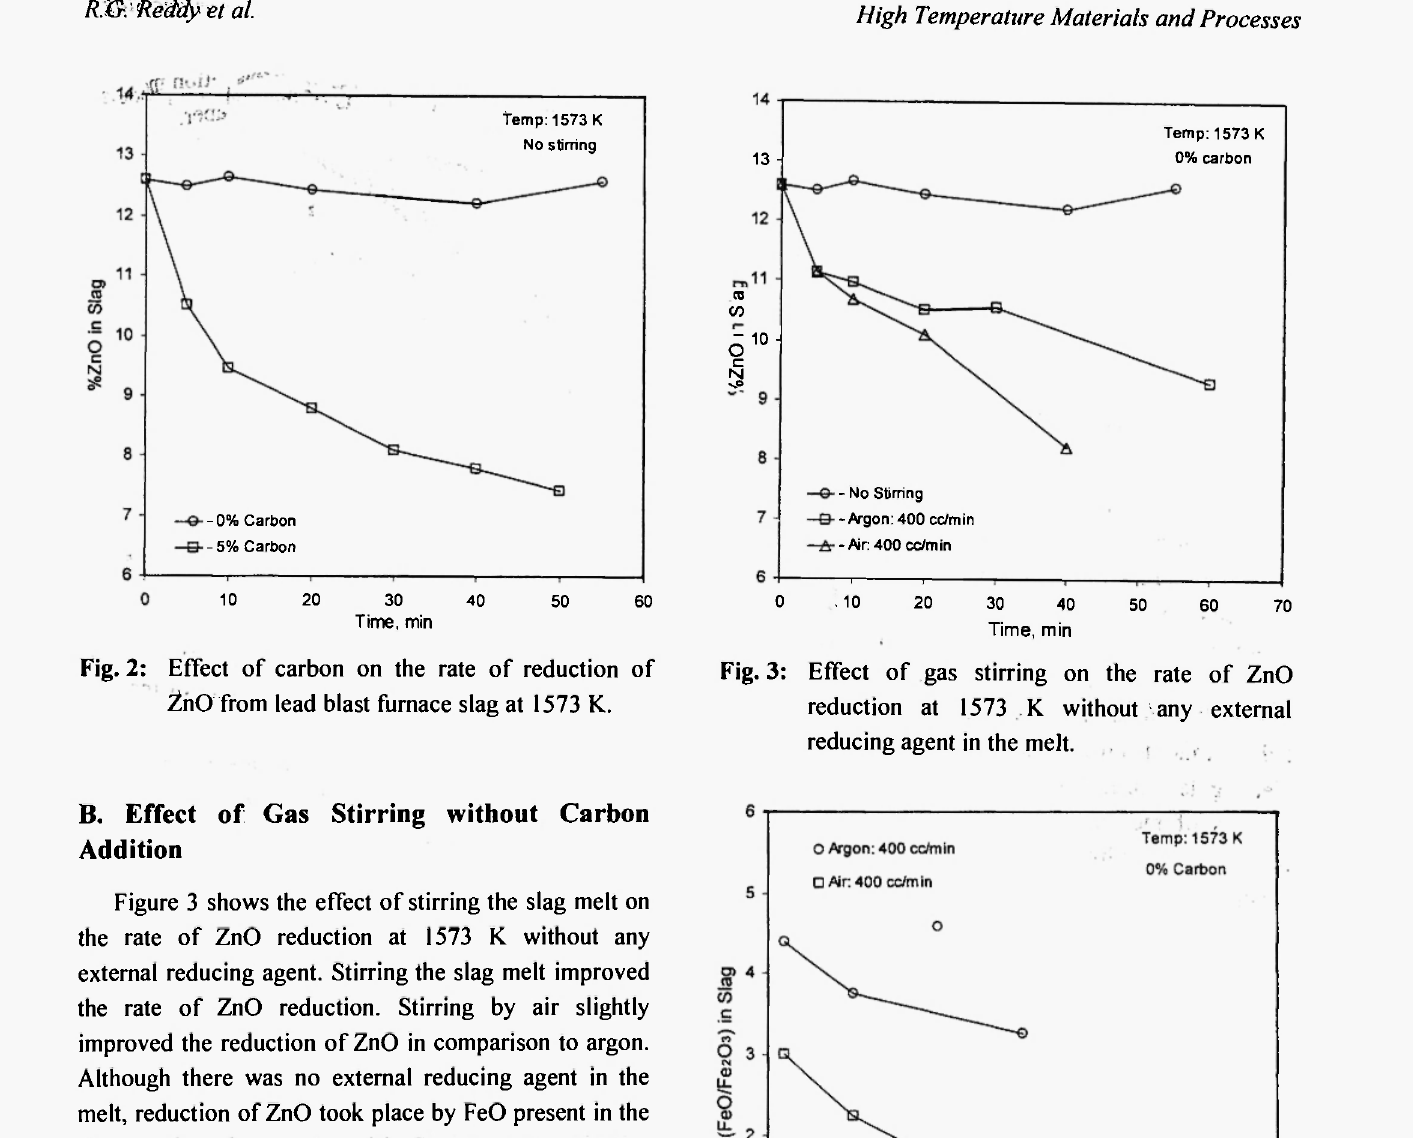
Fig. 3: Effect of gas stirring on the rate of ZnO reduction at 1573 Κ without any external reducing agent in the melt.